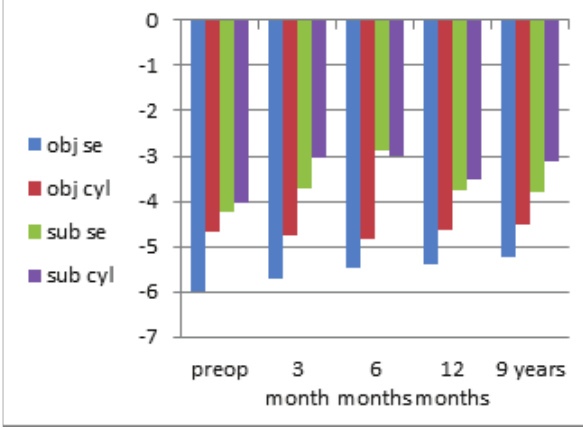
Figure 2. Changes in objective and subjective refraction